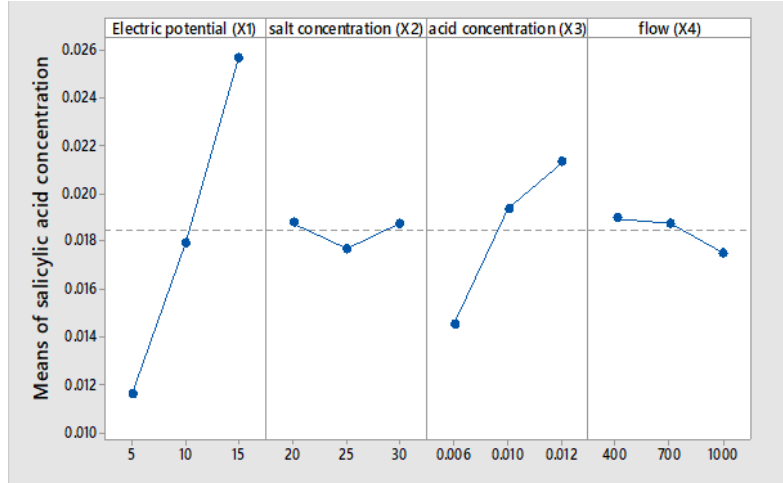
Figure 6. Main Effect Plot for Means of salicylic acid concentration.